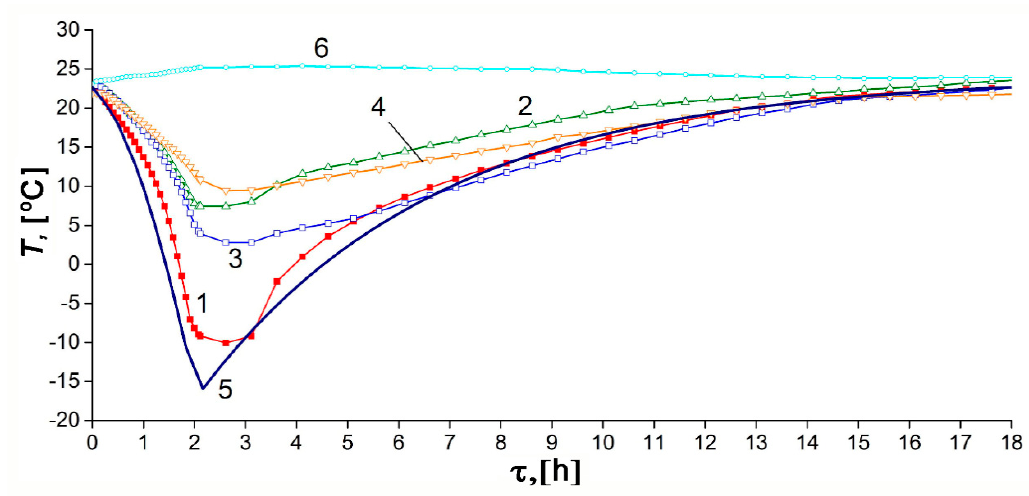
Figure 12. Temporal variations of the temperature inside and outside the adsorber during the discharge cycle under the thermally insulated conditions: curves 1–4 correspond to the TE1–4 sensors readings, respectively; curve 5 is the average adsorber temperature calculated from the model, curve 6 is the ambient temperature.